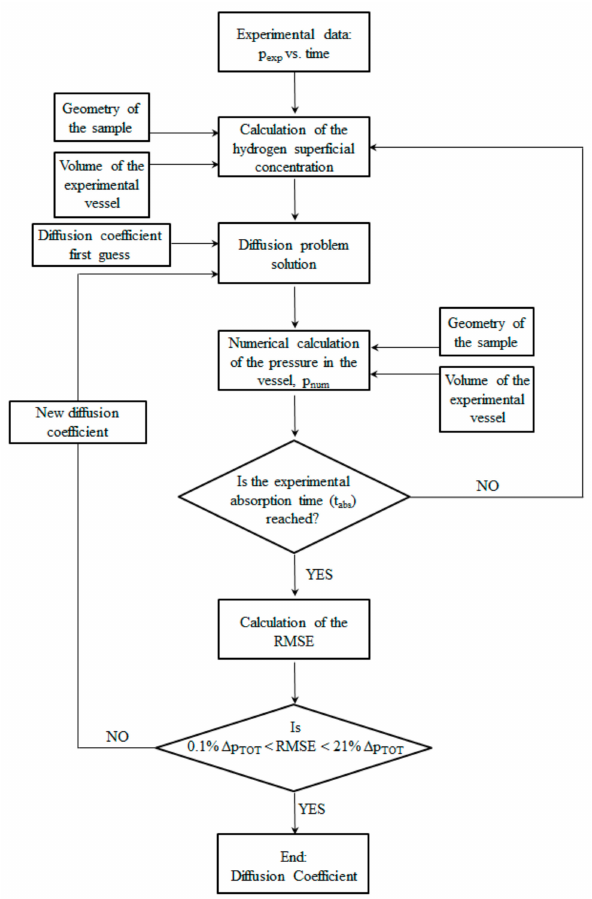
Figure 2. Flow chart of the numerical